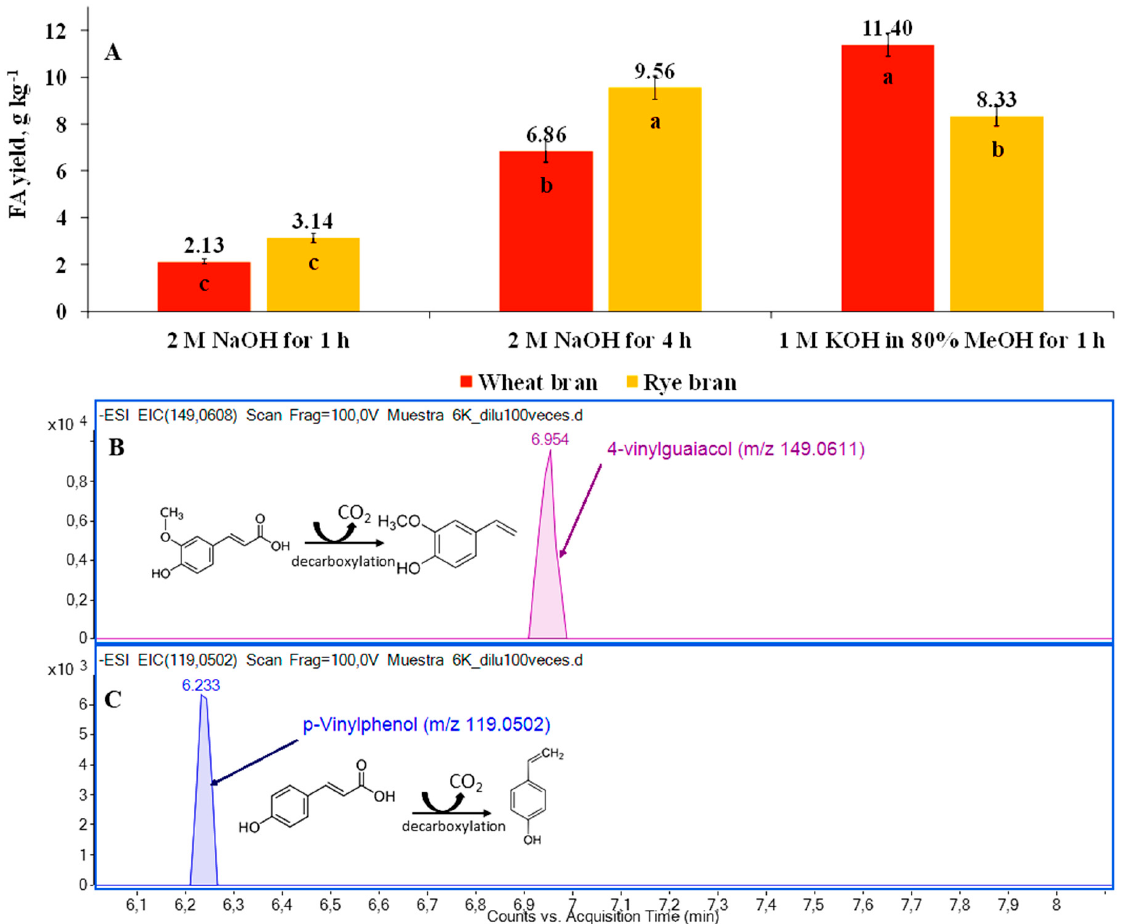
Figure 2. The recovery of ferulic acid (FA) using mild alkali-assisted hydrolysis of wheat and rye bran using either 2 M NaOH or 1 M KOH in 80% MeOH ( A ) and extracted ion chromatograms (EIC) plotted for the degradation products of FA–4-vinylguaiacol ( B ) and p -CA– p -vinylphenol ( C ). Note: Values are means ± SD values of triplicates. Means within the same bran type with different superscript letters (a, b, and c) are significantly different at p < 0.05. DW–dry weight.